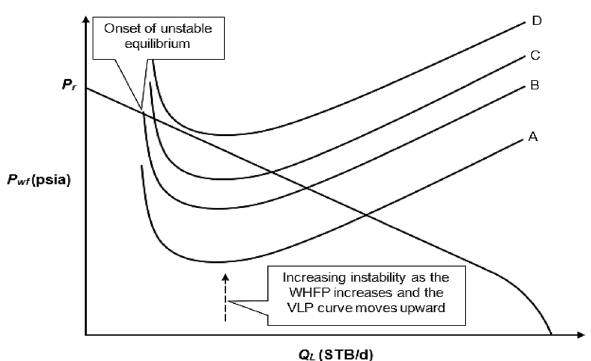
Fig. 2 Performance plots of a well, illustrating the transition from sta‑ ble production to dead